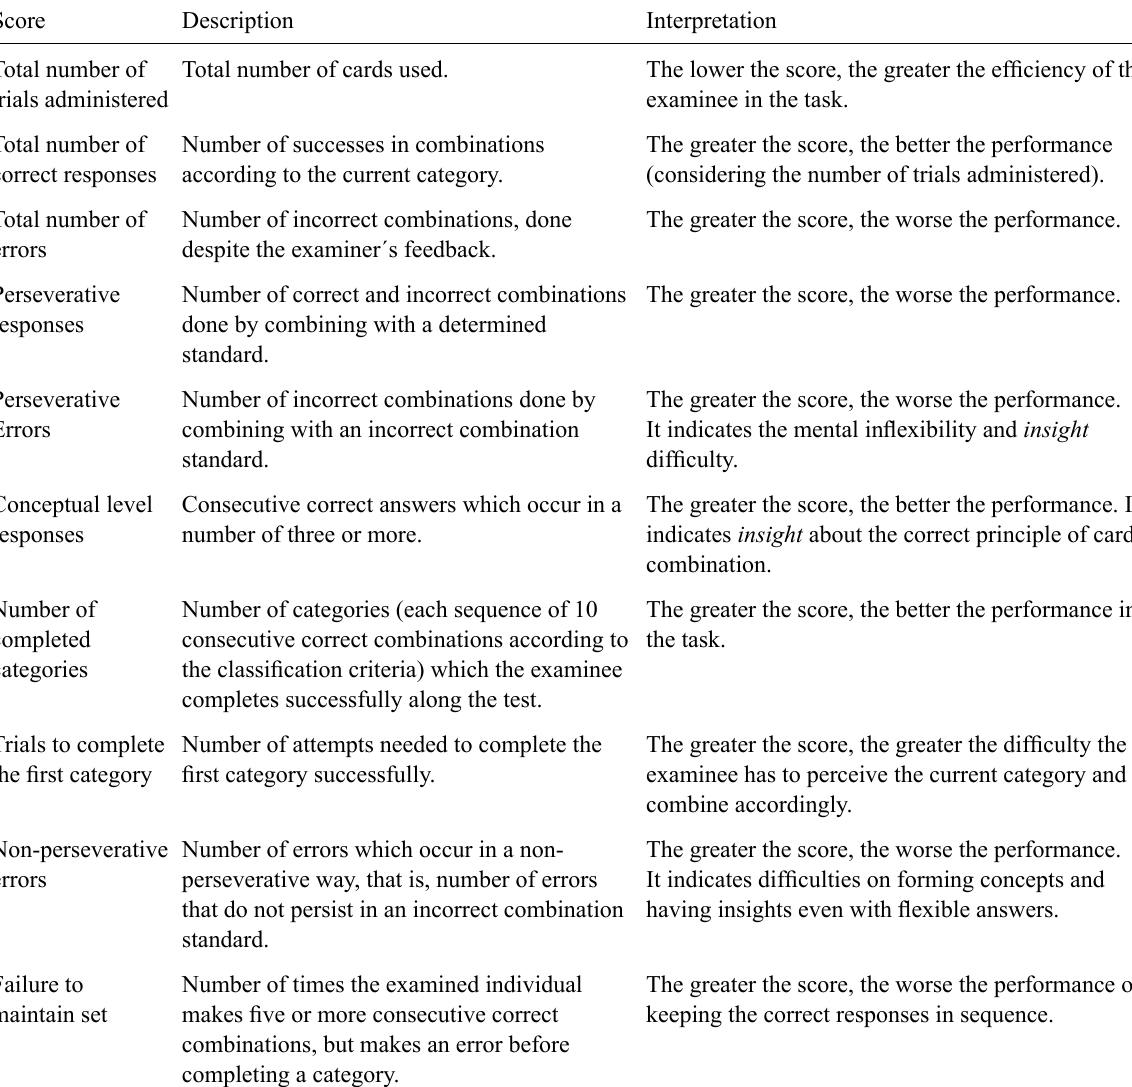
Description and Interpretation of the Wisconsin Card Sorting Test